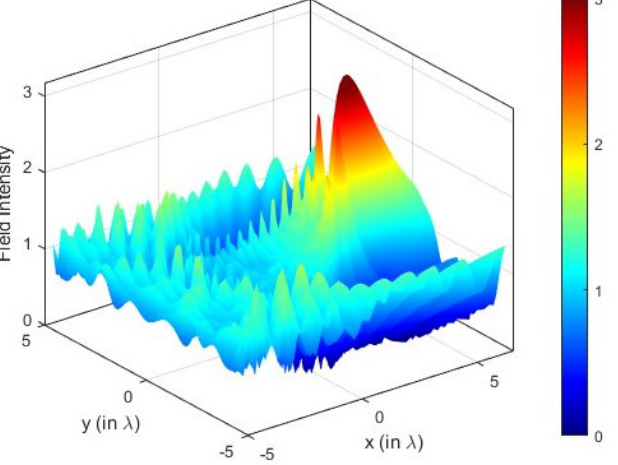
Figure 3. (Color online). Scattering on spheres with diameter: R = 3 and m = 2. Corresponding FWHM of the generated acoustojet is calculated as 0.67 λ . Figure 3 (Color online) has the scattering on spheres with diameter: R = 3 and m = 2. The corresponding FWHM of the generated acoustojet is calculated as 0.67 λ